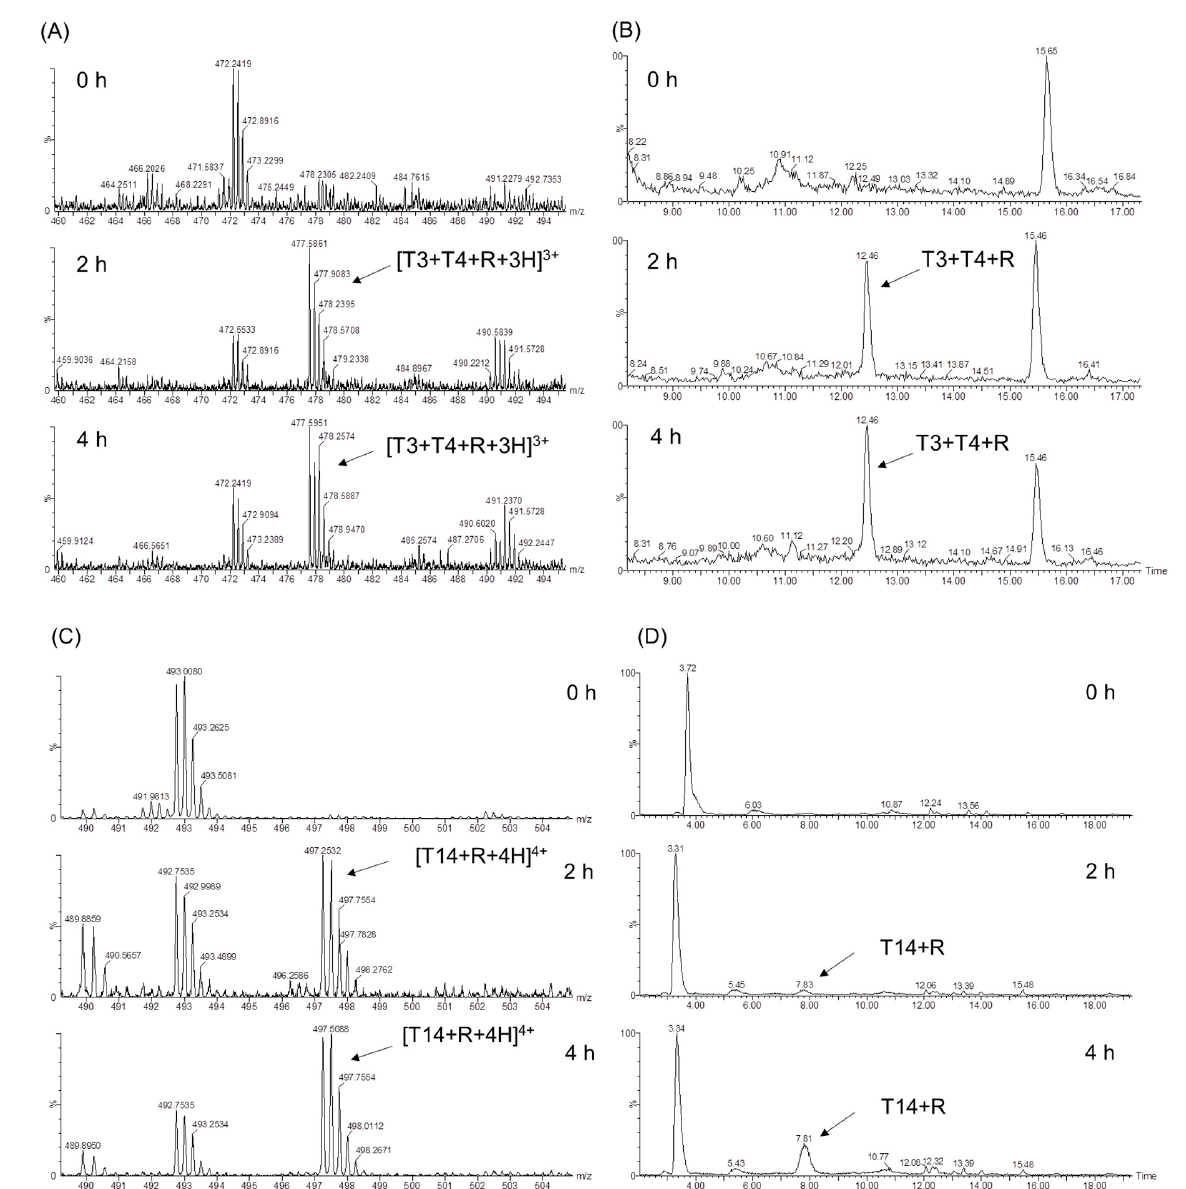
Figure 4. ESI-MS spectra ( A , C ) and extracted ion chromatograms (EICs) ( B , D ) of the trypsin digestion products of HMb induced by D -ribose at different times (0, 2, and 4 h).